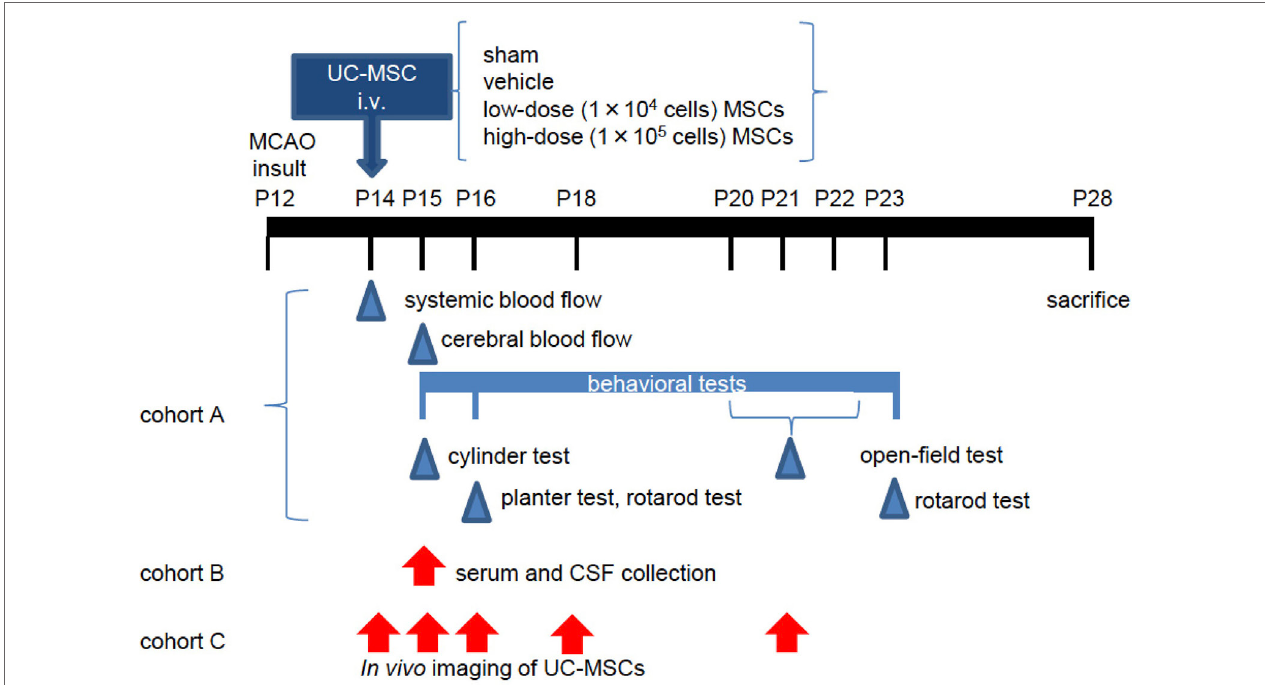
FigUre 1 | The experimental scheme. At postnatal day 12 (P12), mice underwent permanent middle cerebral artery occlusion (MCAO). Two days after the injury (P14), they were administered vehicle or umbilical cord-derived mesenchymal stem cells (UC-MSCs) intravenously (i.v.). (Cohort A) Systemic and cerebral blood flows were measured at P14 and P15, respectively. Neurological behavioral measurements were performed at P15–P23. After sacrifice, morphological and immunohistopathological assessments were conducted in this cohort. (Cohort B) Mouse serum and cerebrospinal fluid (CSF) were collected at P15 for evaluation of a trophic factor. (Cohort C) In vivo imaging was performed at different time points after UC-MSC administration: 3 h, 24 h, 48 h, 4 days, and 7 days after injection.